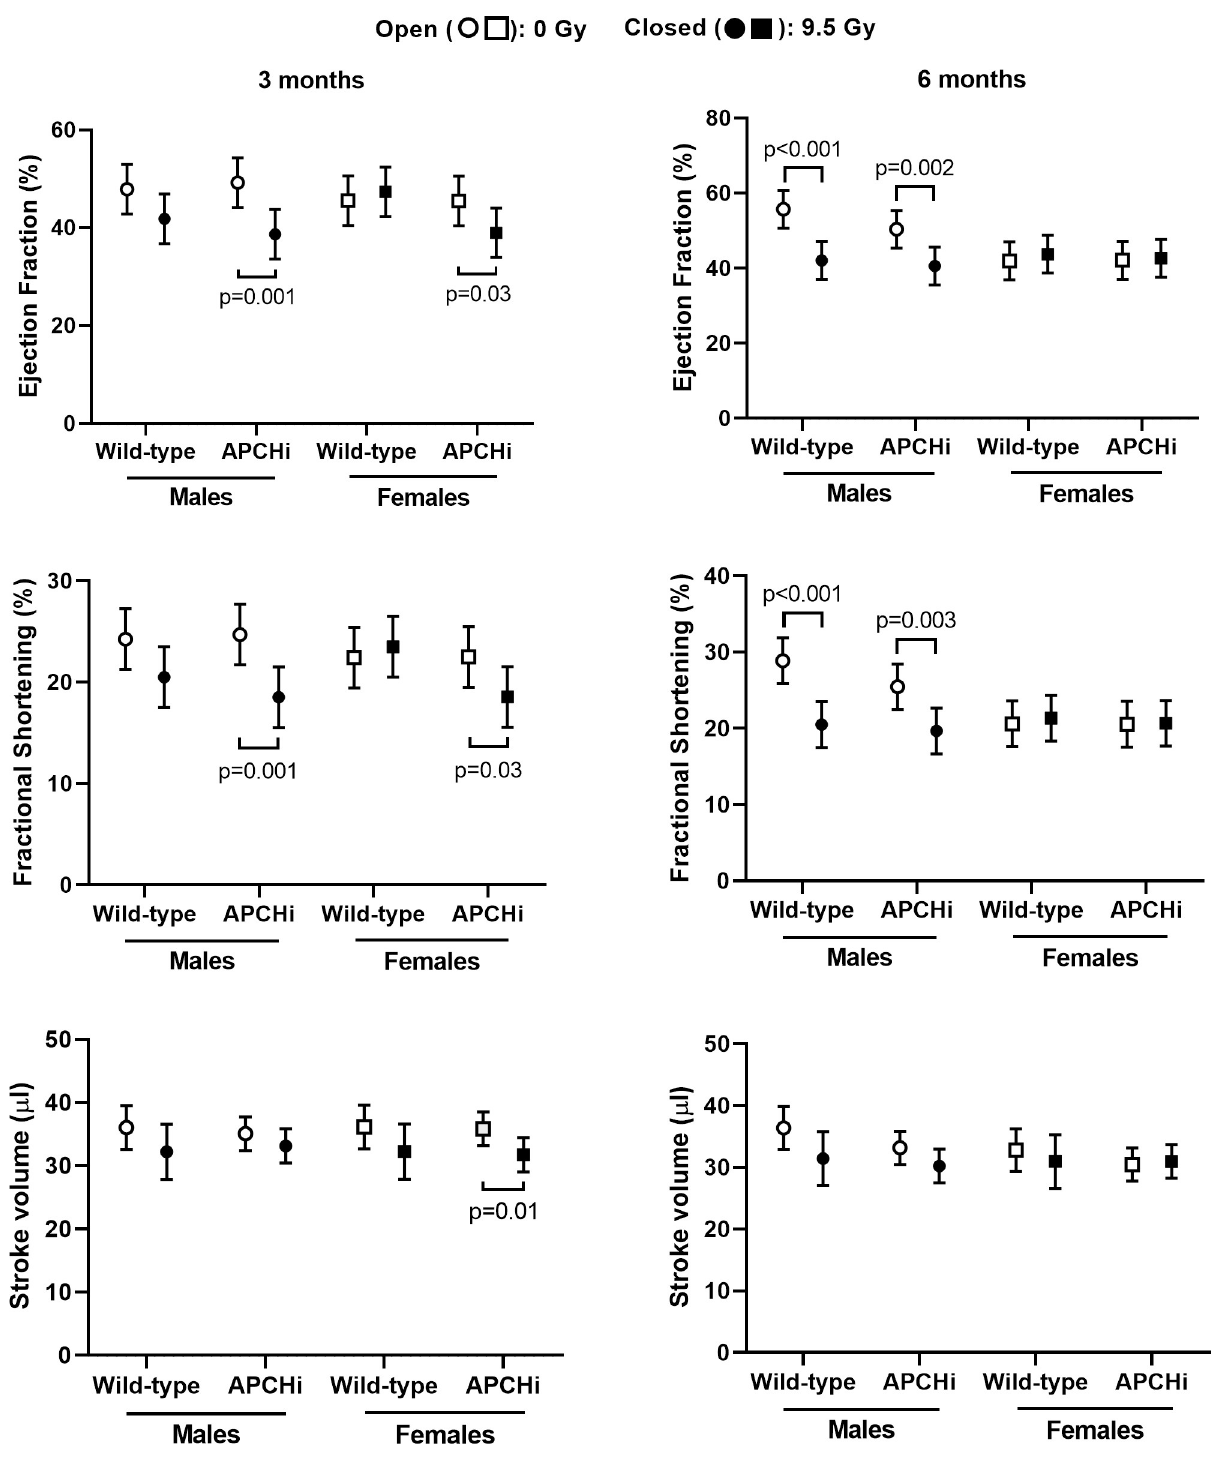
Fig 1. Left ventricular ejection fraction, fractional shortening and stroke volume at 3 and 6 months after irradiation. Means and standard deviations (SD) of the statistical model are shown; n = 9 wild-type males in 0 Gy, 12 wild-type males in 9.5 Gy, 8 APCHi males in 0 Gy, 10 APCHi males in 9.5 Gy, 8 wild-type females in 0 Gy, 8 wild-type females in 9.5 Gy, 10 APCHi females in 0 Gy, and 10 APCHi females in 9.5 Gy. Brackets indicate significant differences between 0 Gy and 9.5 Gy.